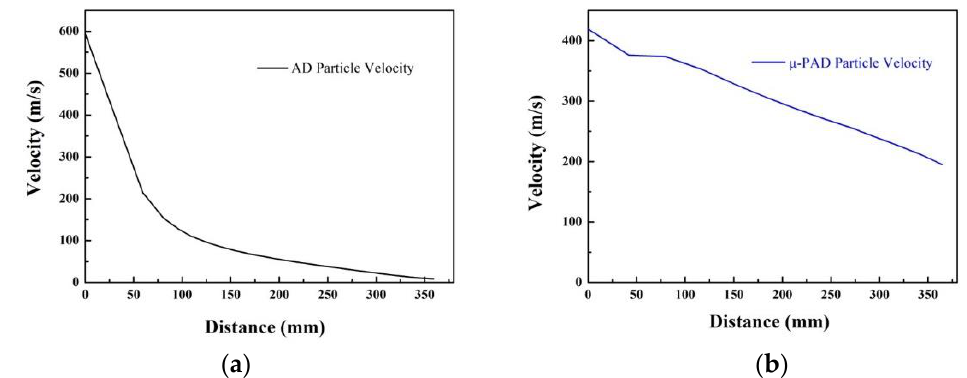
Figure 8. Simulation result of the Z -axis, where particle velocity according to the distance is shown for ( a ) AD and ( b ) μ -PAD.